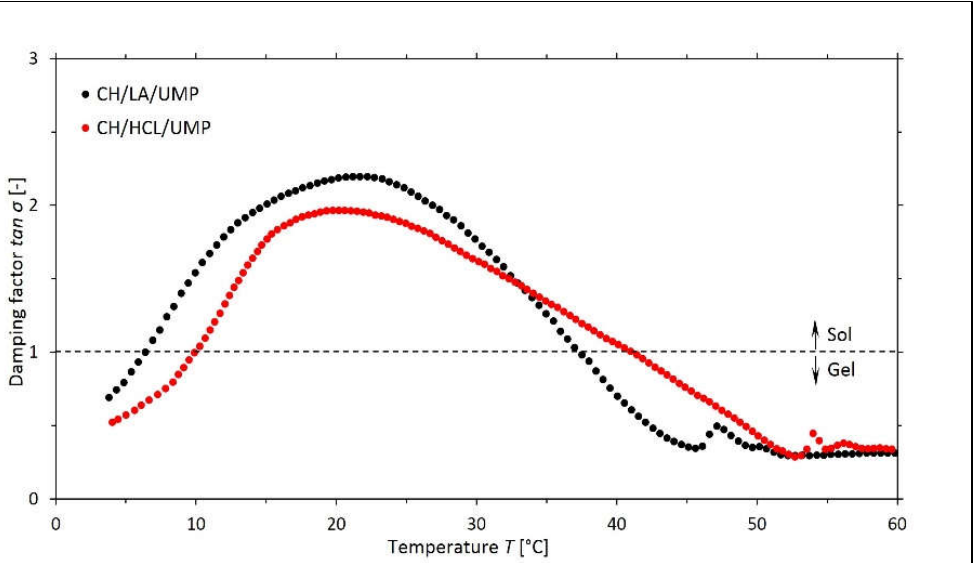
Figure 5. The experimental curves of the changes in the values of the damping factor tan σ = G ′′ /G ′ as a function of the temperature T obtained for the chitosan lactate solutions (the CH/LA/UMP system) and chitosan chloride (the CH/HCL/UMP system) with uridine 5′-monophosphate disodium salt (UMP).